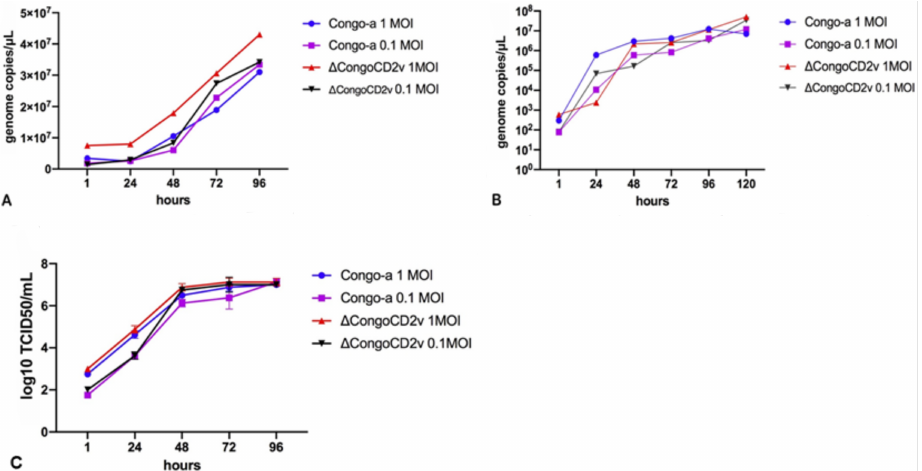
Figure 2. Kinetics of in vitro growth of parental Congo-a and recombinant ASF viruses in pri- mary swine macrophage cultures and COS-1 cells. ( A ): multistep growth curves in primary swine macrophage culture. ( B ): multistep growth curves in COS-1 line cells. ( C ): multistep growth curves in primary swine macrophage culture, expressed in log10 TCID50/mL. An analysis was conducted using Graphpad Prism software version